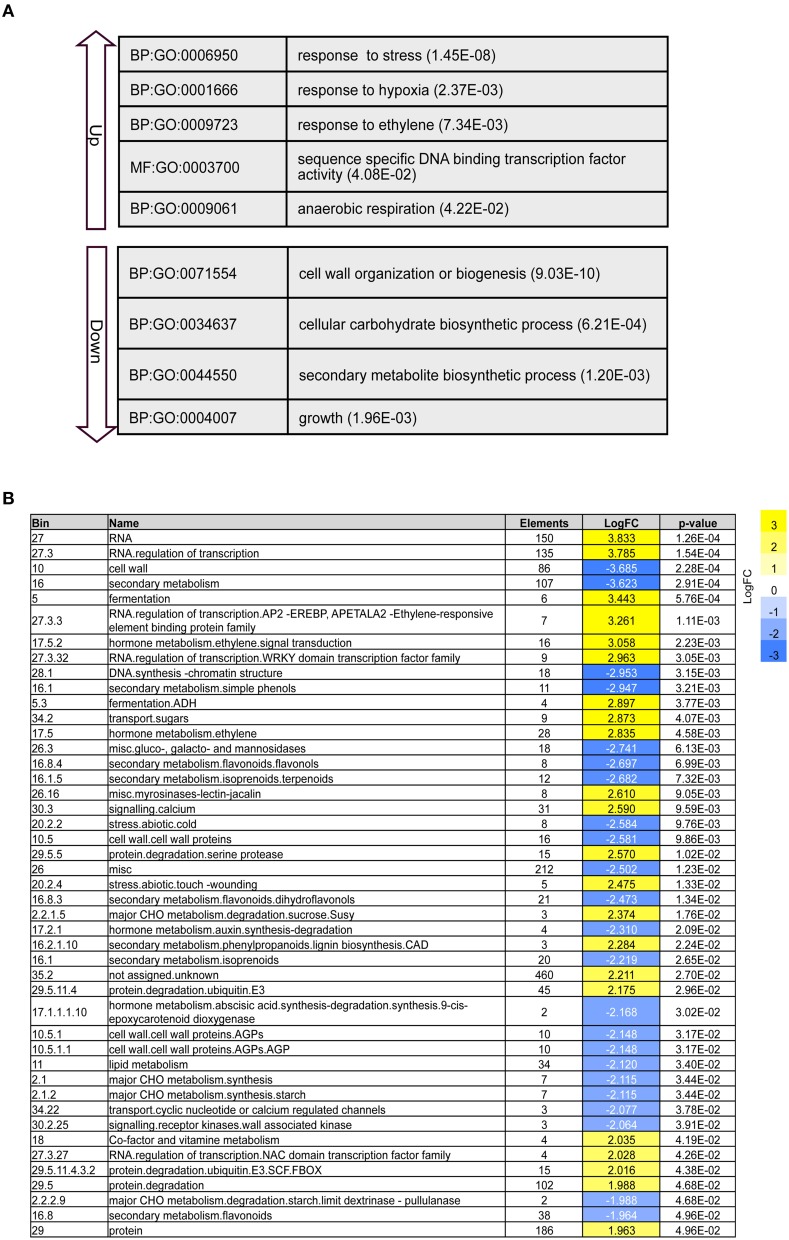
Waterlogging reprograming transcriptome of Jatropha roots. (A) Selected gene ontology (GO) categories (p-values calculated by GOHyperG) from up-regulated (Up) and down-regulated (Down) groups are shown. (B) PAGEMAN enrichment analysis with significant up/down-regulation (Wilcoxon rank sum test; p-value < 0.05).